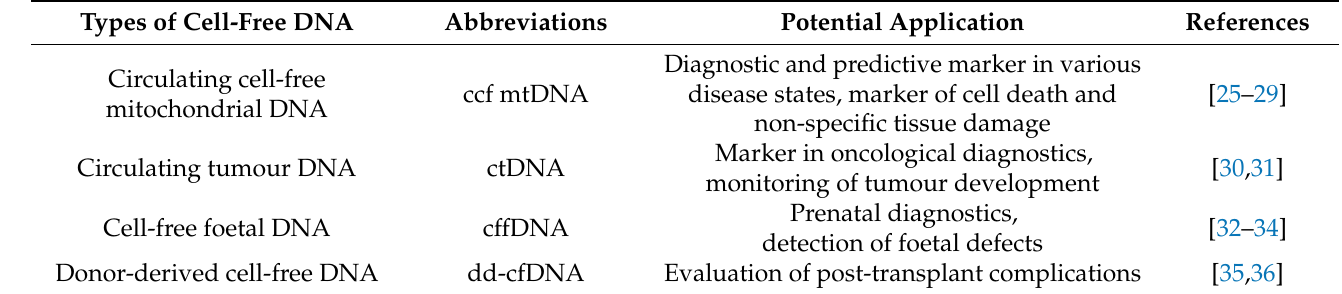
Table 1. Types of cell-free DNA (cfDNA) and their potential